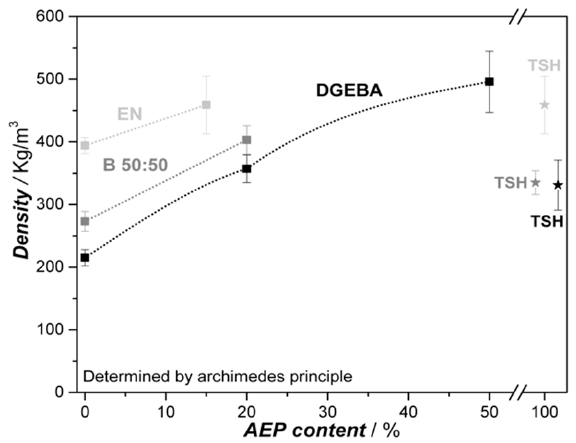
Figure 10. Foam density of different resin samples in dependency of AEP content, 0% means use of B-AEP only, and the TSH benchmark, where 100% AEP is required.